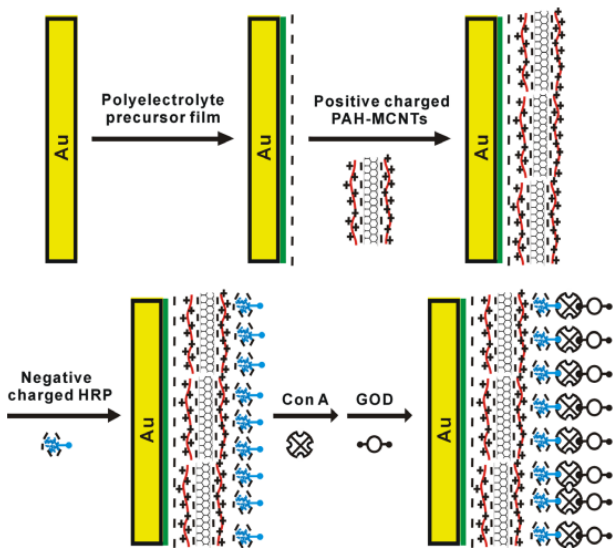
Figure 5. Schematic illustration of construction of a bi-enzyme bio-nano-multilayer electrode based on functionalized CNTs and sugar–lectin bio-specific interactions. Reprinted from [69] with permission from the Elsevier.